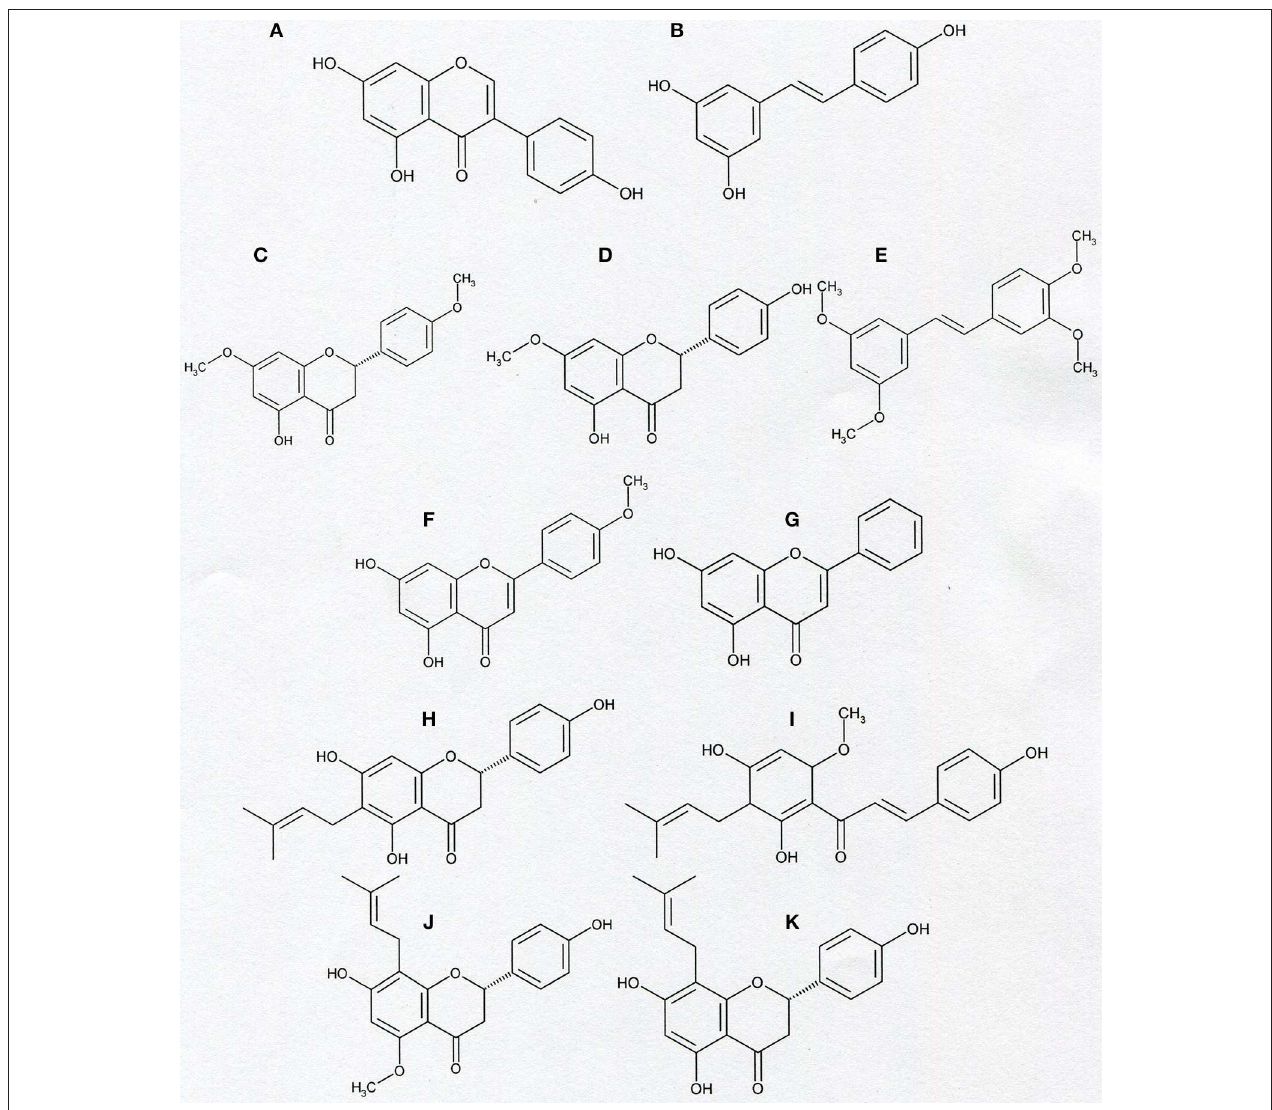
FIGURE 6 | Chemical structure of genistein (A) , resveratrol (B) , naringenin-4 ′ ,7-dimethylether (C) , naringenin-7-methylether (D) , tetramethoxy- piceatannol (E) , acacetin (F) , chrysin (G) , and prenyl derivatives: 6-prenylnaringenin (H) , xanthohumol (I) , isoxanthohumol (J) , and 8-prenylnaringenin (K) .